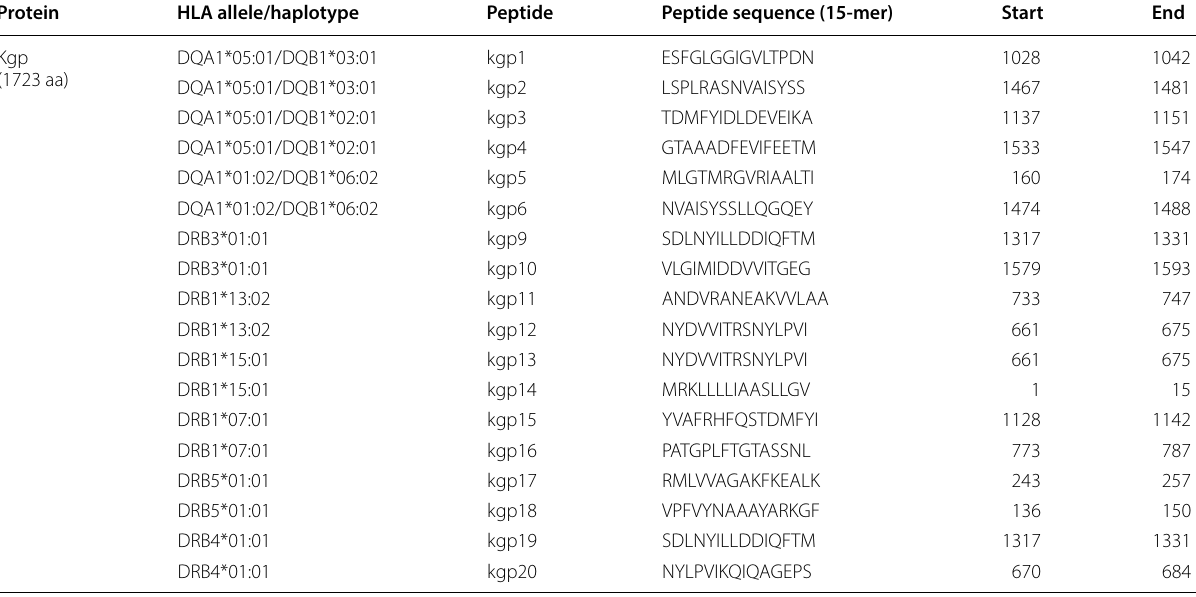
Start and end correspond to the positions in the Kgp sequence. For Kgp 9/19 and Kgp 12/13, only one sequence was